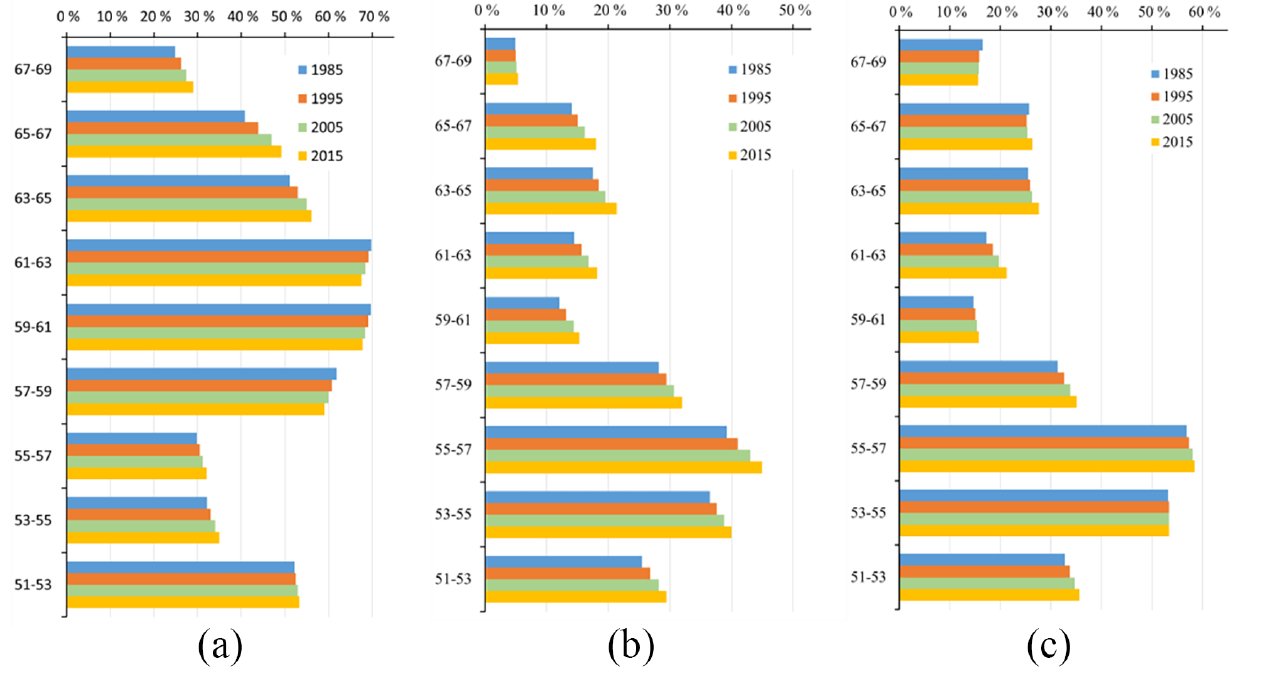
Figure 6. Differences between the rates of broad-leaved and coniferous forest coverage as measured by (a) R cl , (b) R bl and (c) R bf . Table 4. Quantitative details of the changes in forest types.